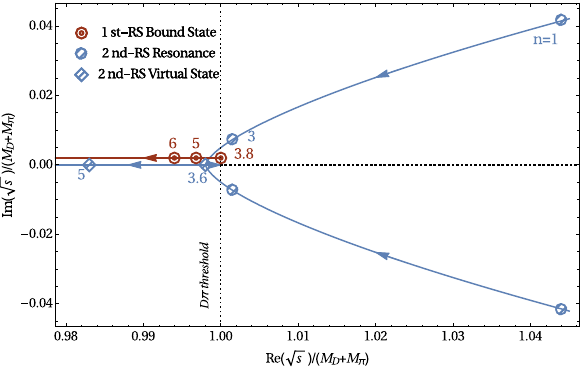
( 2317 ) with varying M π s 0